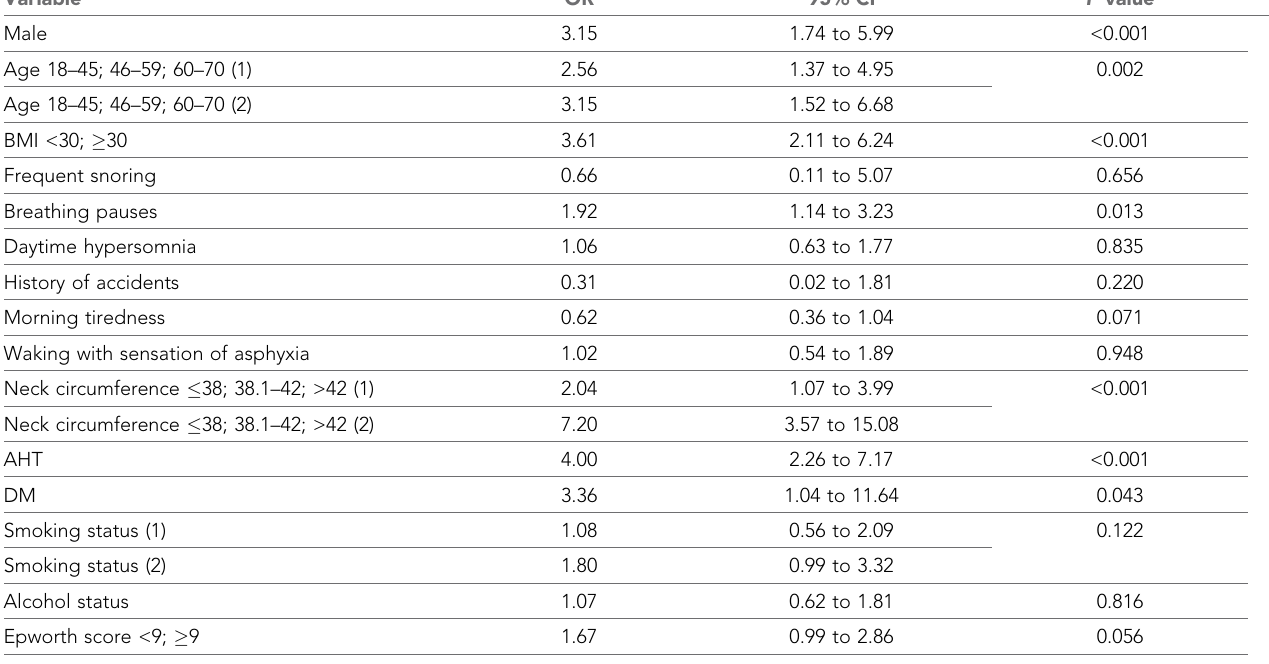
Table 3. Derivation sample. Univariate logistic regression for the primary variable ’therapeutic decision’. Selection of variables for the final model. Variable